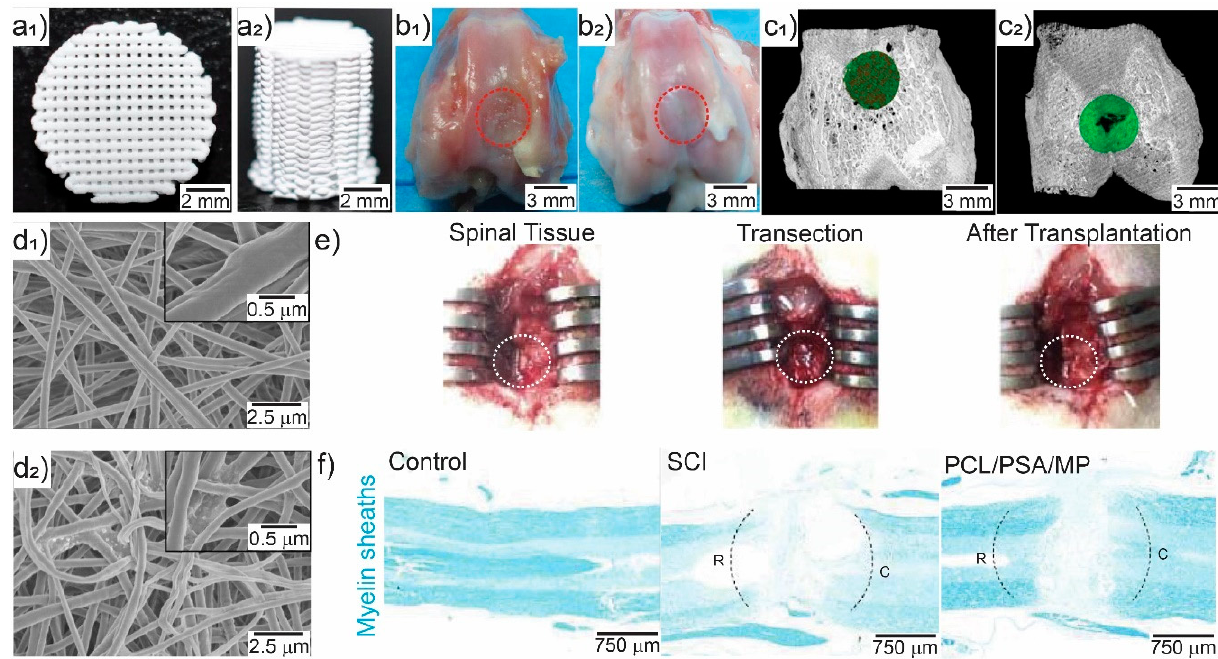
Figure 2. Scaffolds combining synergistic biochemical cues for TERM. ( a 1 , a 2 ) Gross morphology and microstructure of Li- and Si-containing scaffolds. ( b 1 – c 2 ) In vivo osteochondral regeneration efficiency for Li- and Si-containing scaffolds 12 weeks postsurgery: macrophotograph ( b 1 , b 2 ) and transverse view of 3D reconstruction of microcomputed tomography ( c 1 , c 2 ) showing the defects in control (untreated) ( b 1 , c 1 ) and implanted with scaffold ( b 2 , c 2 ). In microcomputed tomography the off-white color, green color and red color stand for primary bone, new bone, and scaffold, respectively. ( d 1 , d 2 ) SEM morphologies of untreated and after degradation for 4 weeks of PCL/polysialic acid/methylprednisolone nanofiber scaf- folds, respectively. ( e ) Photographs of spinal tissue, spinal cord transection and spinal cord after nanofiber transplantation. ( f ) Histology and quantification of myelin sheaths 7 weeks postoperation. The dotted lines indicate the plane of injury. The letter R and C represents rostral and caudal spinal cord. SCI: spinal cord injury. ( a 1 – c 2 ) adapted with permission from [140] , Elsevier, 2017. ( d 1 – f ) adapted with permission from [141] , Elsevier, 2018. Incorporating various therapeutic molecules such as antibiotics and growth factors within the scaffold has been also explored as means to enhance tissue engineering func- tionalities. For example, Escobar et al. reported the use of mesoporous titania films for gentamicin loading and release to prevent Staphylococcus aureus colonization. In addi- tion, these mesoporous materials were surface functionalized with BMP-2 to promote MC3T3 preosteoblastic cell line proliferation and differentiation [142]. In reference [141], Zhang et al. developed a multifunctional nanofiber scaffold encapsulating glucocorticoid methylprednisolone as an immunomodulatory drug for treatment of spinal cord injury. Using the electrospinning technique, the authors combined PCL and polysialic acid (a natural, biodegradable polysaccharide capable of controlling central nervous system de- velopment by modulating cell adhesion and promoting axonal growth), and methylpred- nisolone (a drug capable of inhibiting spinal cord early secondary inflammation and lipid peroxidation). The nanofiber scaffold was biodegradable (Figure 2(d 1 ,d 2 )), biocompatible and could sustain the local release of methylprednisolone, which would bypass the severe adverse effects of high systemic dosage. Scaffolds were transplanted into spinal cord tran-